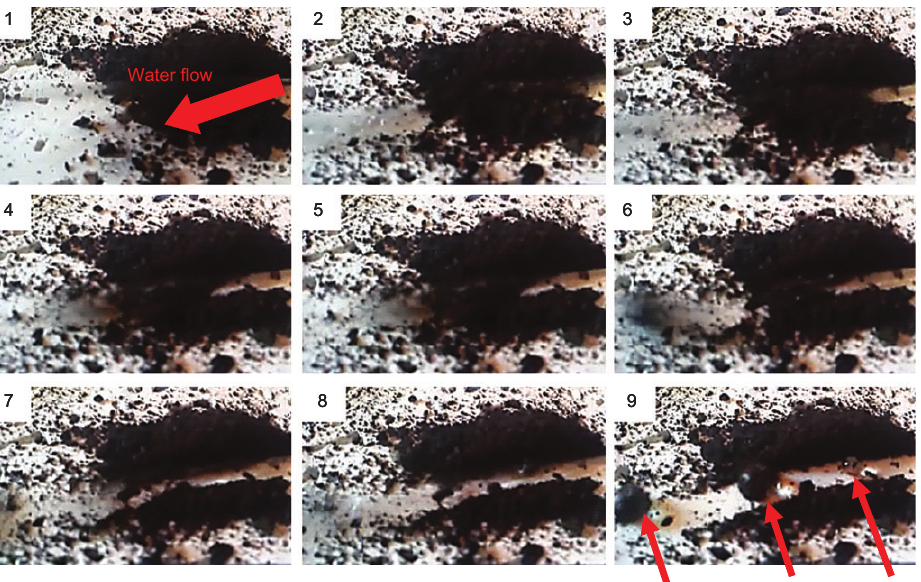
Figure 8 The self-cleaning process of a water-repellent surface is demonstrated with these successive snapshots. The surface of a concrete segment, covered with a water-repellent film, was intentionally contaminated with black dust particles. Water drops were left to roll off toward the direction shown by the arrow (snapshot 1). Powder particles were gradually removed by the water drops, thus creating a channel of clean surface.